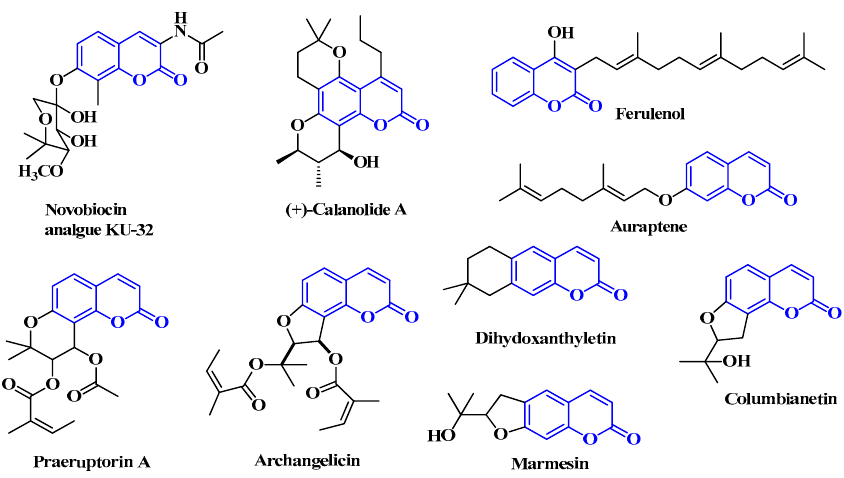
Figure 1. General structures of coumarin molecules possessing biological activity.